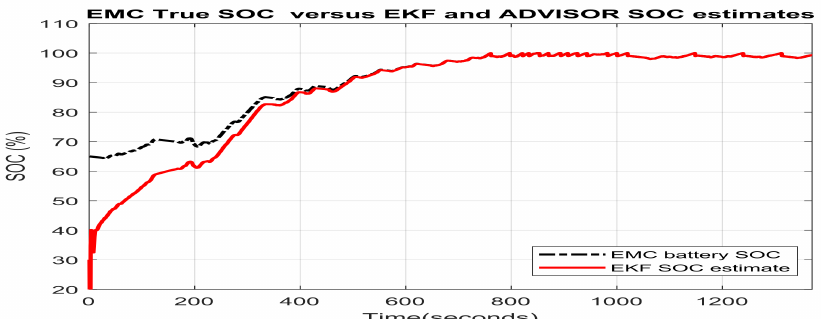
Figure 22. The robustness of EKF SOC estimator to simultaneous changes in SOC initial value and 50% decrease in the nominal value of Li-Ion battery